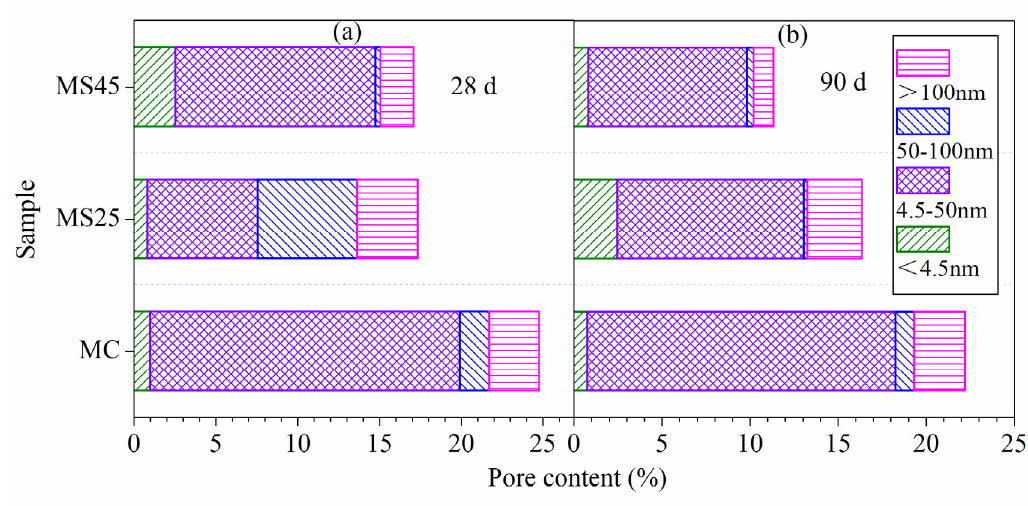
Figure 9. The pore size distribution of hardened pastes under temperature-matching curing conditions: ( a ) at 28 d; ( b ) at 90 d.